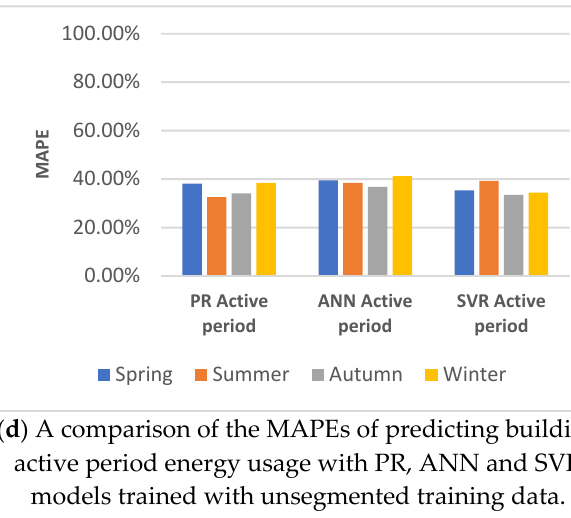
( a ) A comparison of the MAPEs of predicting building dormancy period energy usage with PR, ANN and SVR models trained with dormancy period training data.